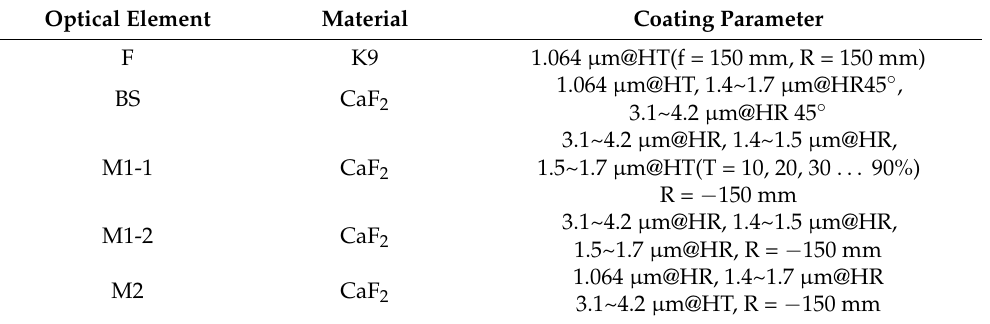
Figure 1. Schematic diagram of experiment setup. Table 1. Coating